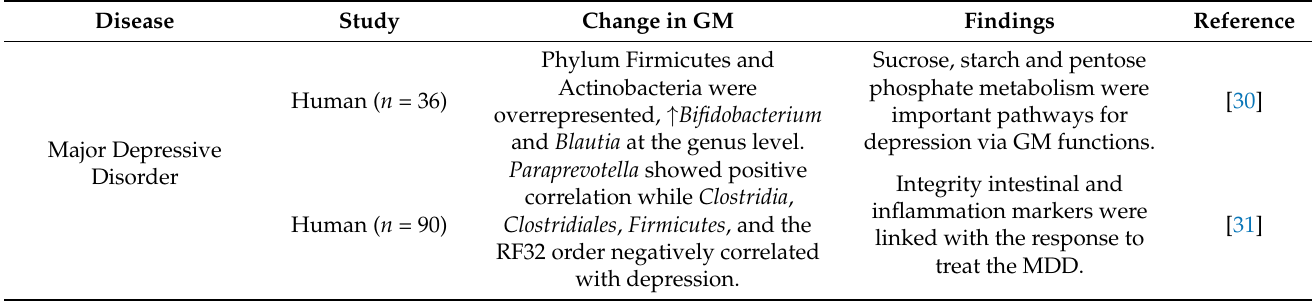
Table 1. Neurodegenerative diseases influenced by the change of GM (induced by oxidative stress and inflammation). Disease Study Change in GM Findings